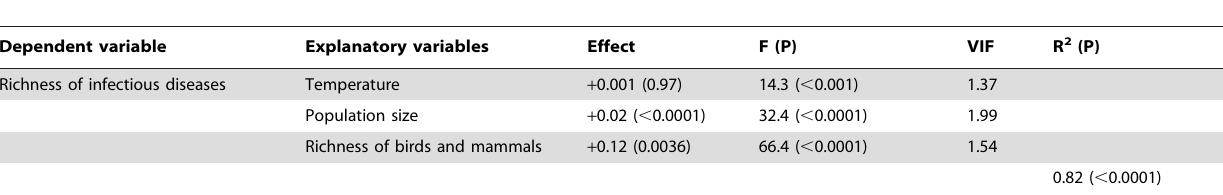
Table 1. Summarized results for a General Linear Model explaining the richness of infectious diseases in Asia-Pacific.